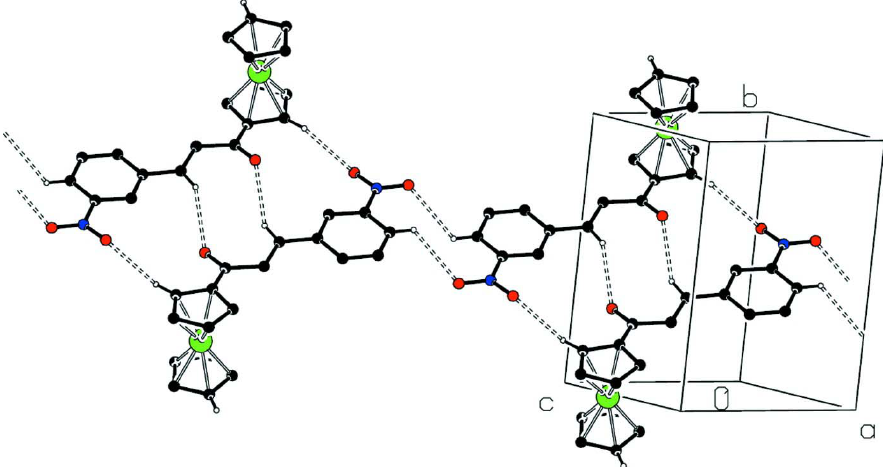
Figure 2 Part of the crystal structure of the title compound, showing the formation of a R bonded chain along a axis, which is built by three C—H···O inter-molecular hydrogen bonds (dashed lines). For the sake of clarity, H atoms not involved in hydrogen bonding have been